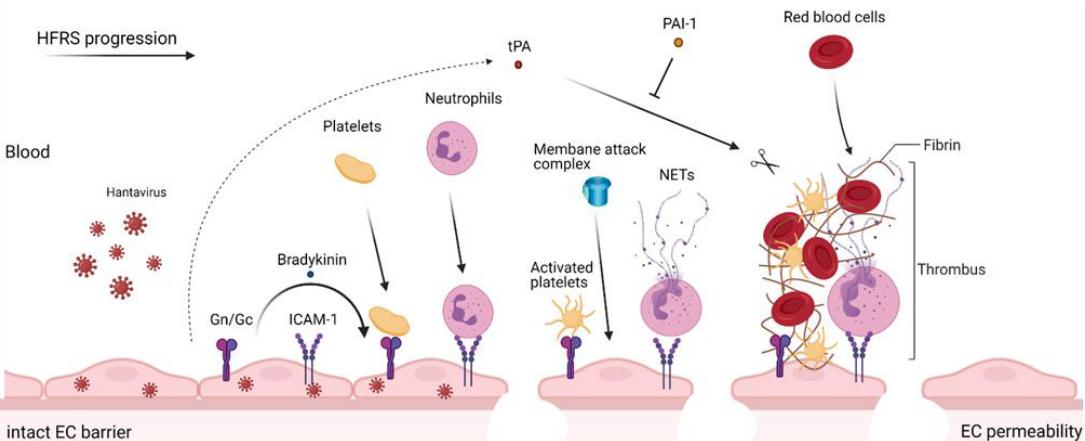
Figure 1. Vasculopathy in HFRS. Hantaviruses infect endothelial cells (EC) lining the vasculature. The infected ECs express viral Gn/Gc glycoproteins and upregulate ICAM-1 adhesion molecules, to which circulating platelets and neutrophils adhere. The interactions activate platelets and neutrophils (through neutrophil extracellular traps, NETs), which promote coagulation through thrombus and fibrin clot formation. At the same time, the infected ECs induce the local production of bradykinin that is released into the bloodstream, which, together with complement membrane attack complex, compromises the EC barrier function, resulting in increased blood flow into tissues. Another factor produced by infected ECs, tissue plasminogen activator (tPA) solubilizes blood clots and thereby contributes to EC permeability. The activity of tPA is inhibited by plasminogen activator inhibitor (PAI)-1 that is upregulated in the more severe HFRS cases (caused by DOBV hantavirus). This image was created with